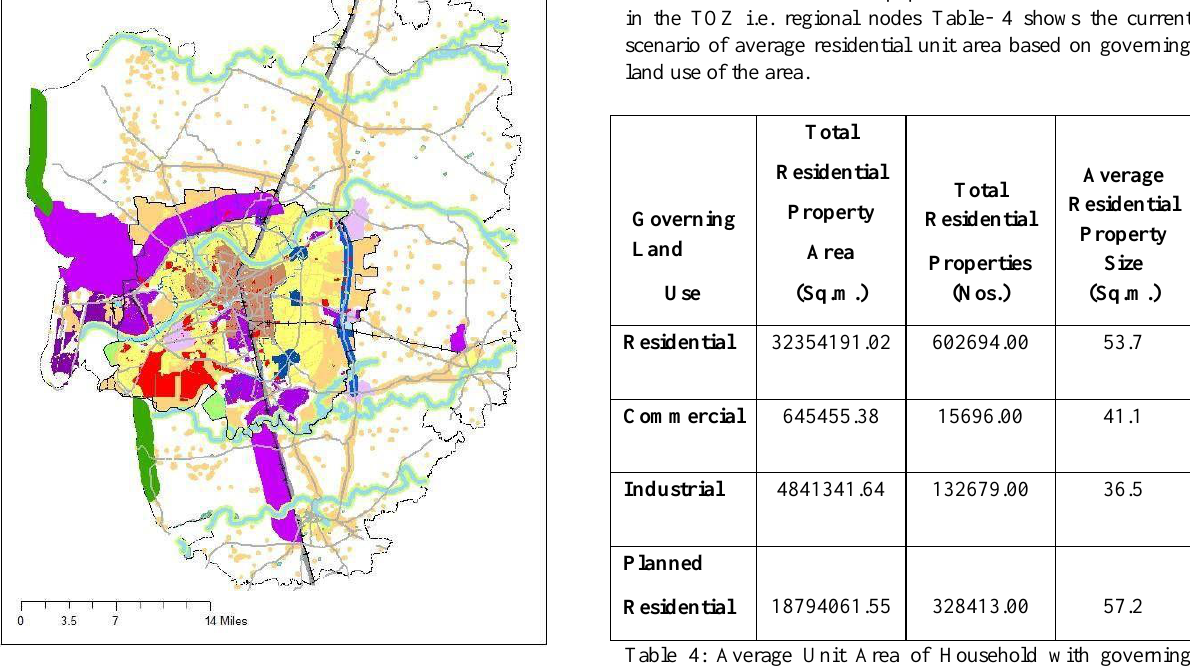
Figure 2: Urban Sprawl Scenario Surat